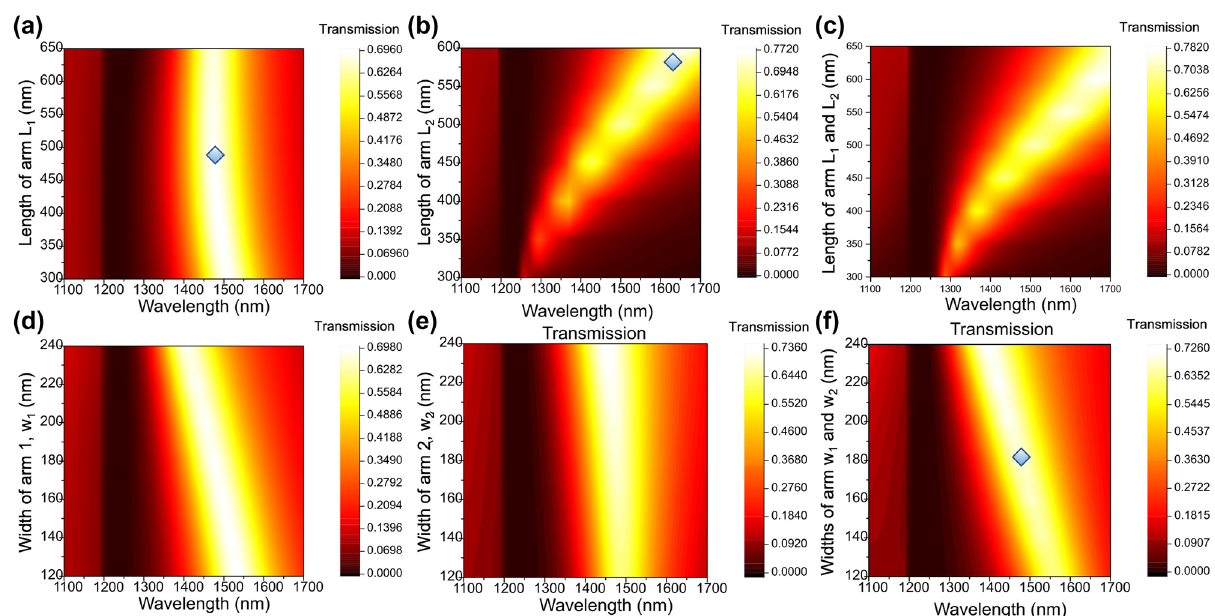
Figure 2: Map of transmission spectra with geometric parameters of nanoslit structures. Wavelength-dependent transmission with varying (a) length of the longer arm of nanocross ( L 1 ) (width and length of shorter arm ( L 2 ) are fi xed at 180 and 480 nm), (b) length of the shorter arm of nanocross ( L 2 ) (width and length of longer arm ( L 2 ) are fi xed at 180 and 580 nm), (c) and length of both arms of nanocross( L 1 and L 2 ) (widthis fi xed at 180 nm). Dependance of transmission peak for varying(d) width of longerarm of nanocross, (e) width of longer arm of nanocross, and (f) width of both arms of nanocross. The rhombus symbols in (a), (b), and (f) indicate the fi nal designed structure of unit nanocross for asymmetric metasurfaces.